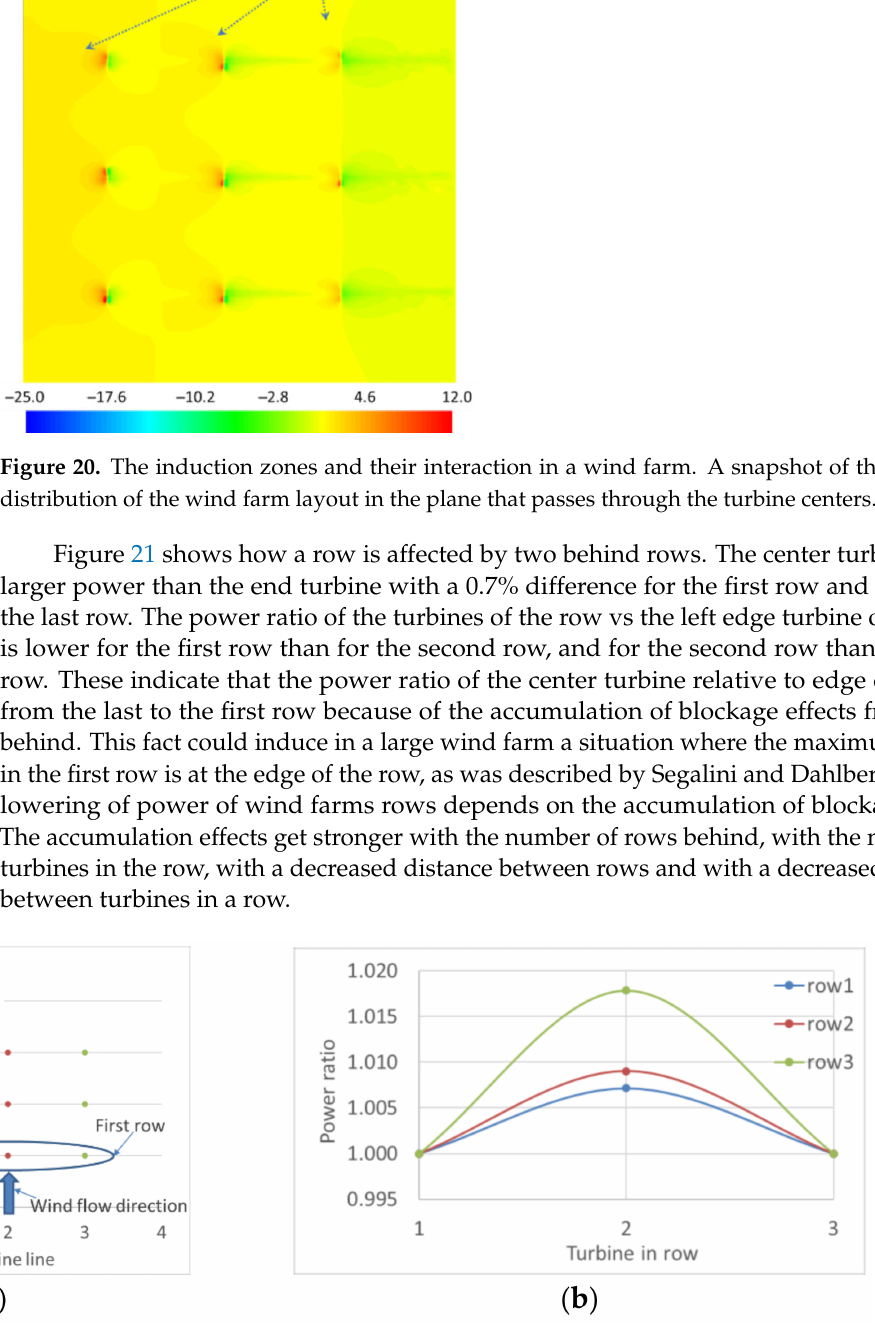
Figure 21. The blockage effect in the wind farm: ( a ) the details of the wind farm layout; ( b ) the power ratio output of turbines vs. the left edge turbine of the